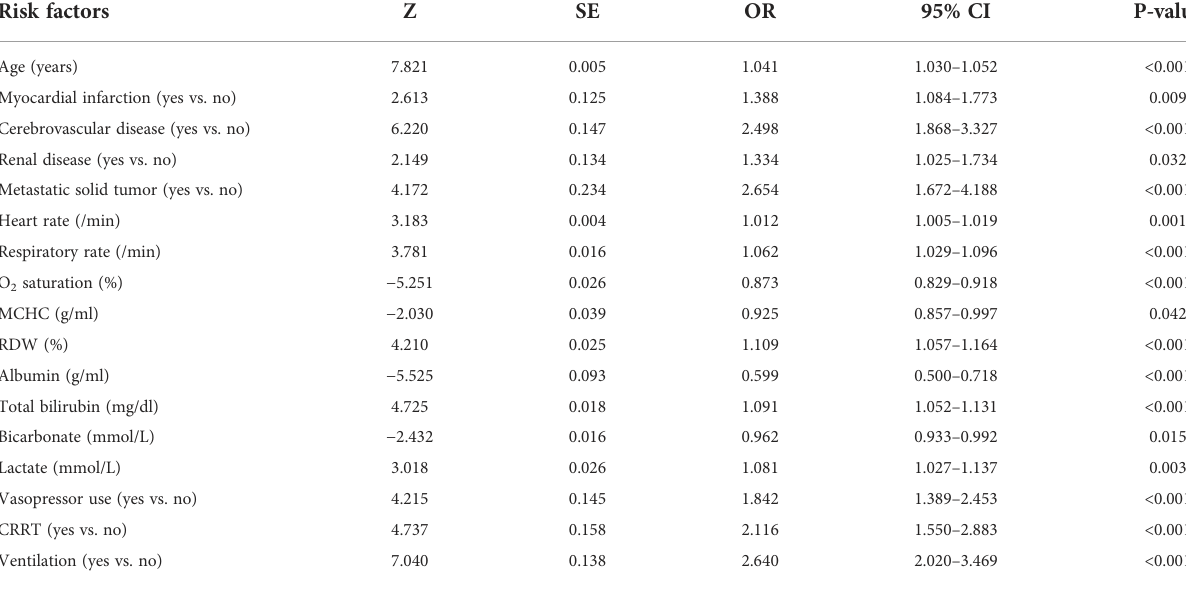
TABLE 2 Multivariate logistic regression analysis with lasso regularization of in-hospital mortality in the training set. Risk factors